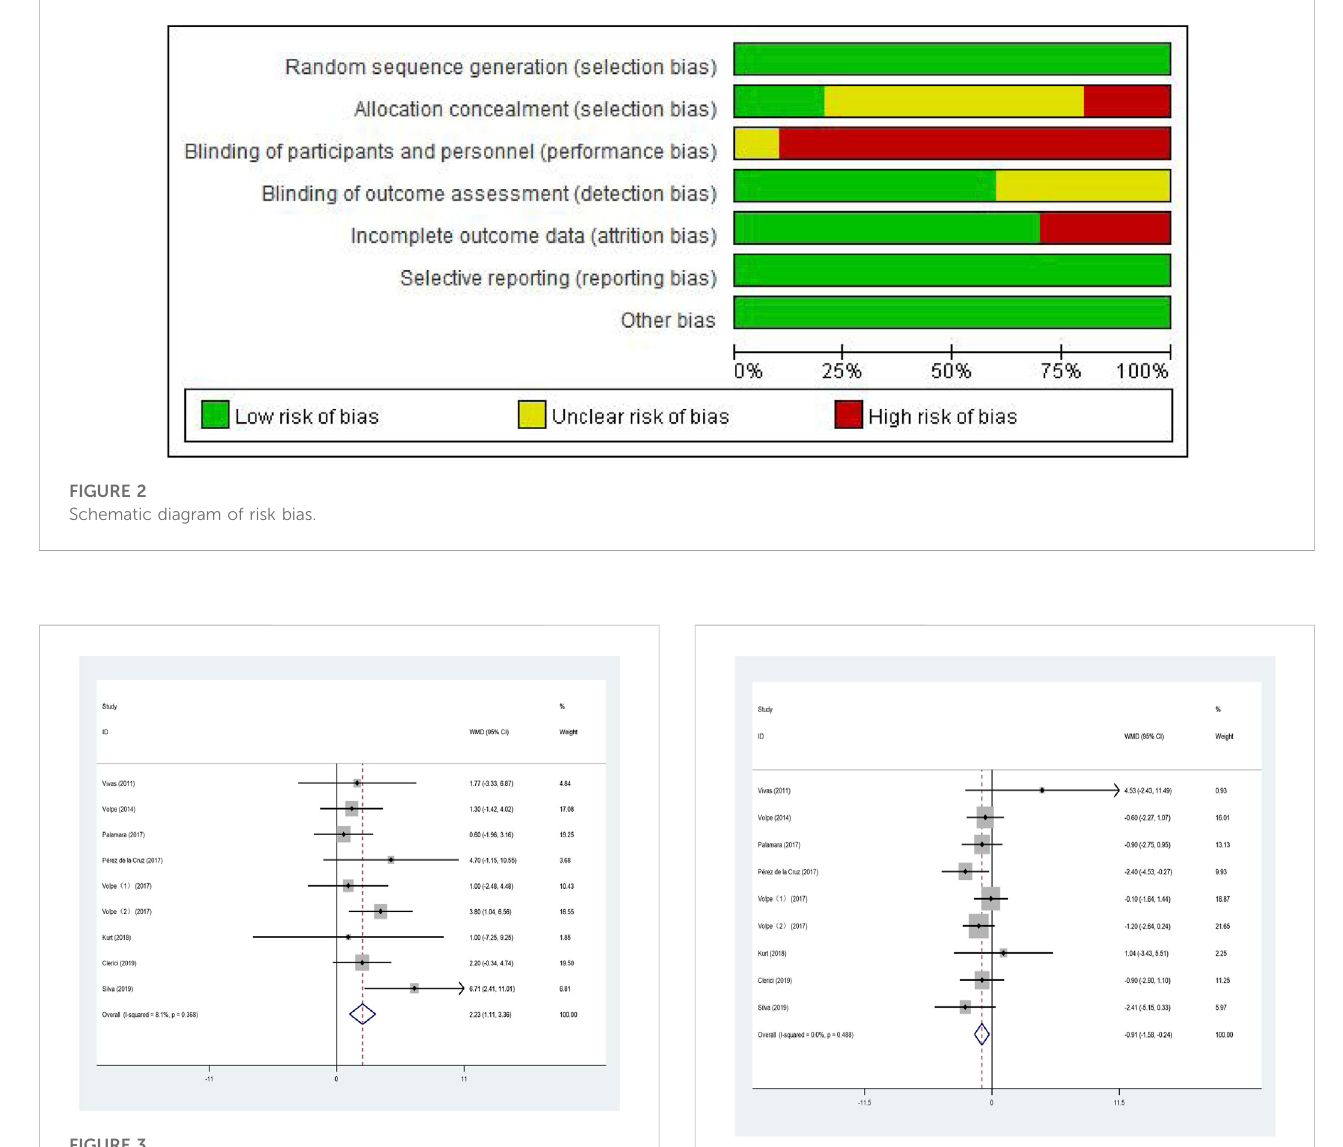
FIGURE 3 Effects of aquatic exercise on balance function in PD patients. FIGURE 4